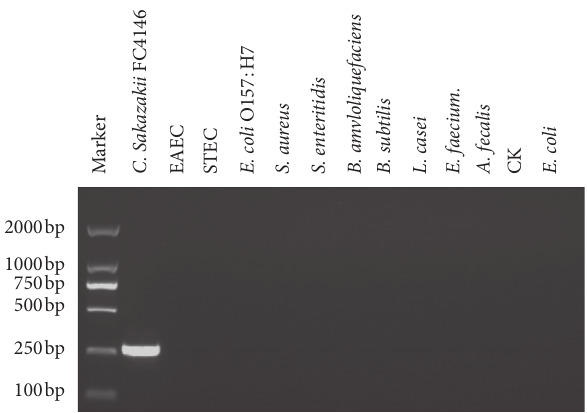
Figure 2: Specificity analysis of 16S–23S PCR result.